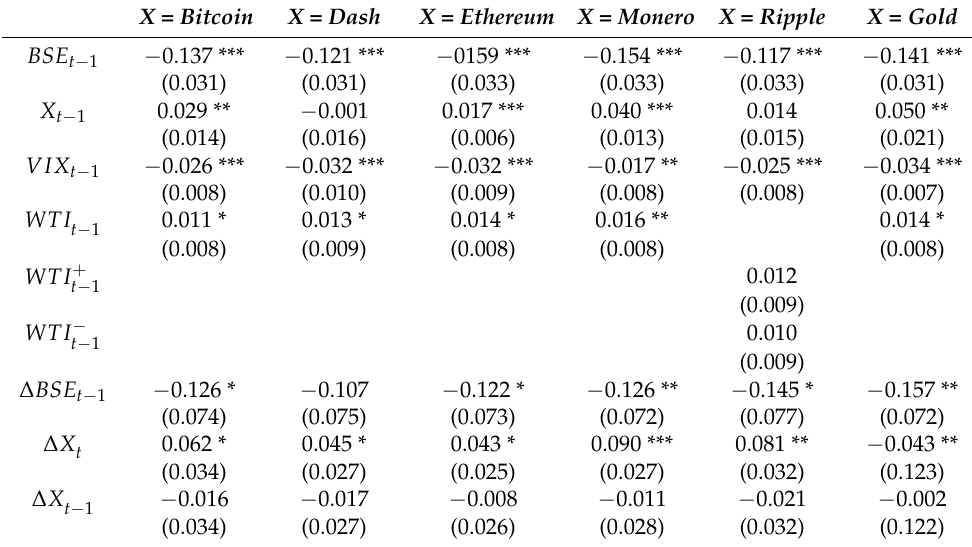
Table 10. Estimation results for BSE during